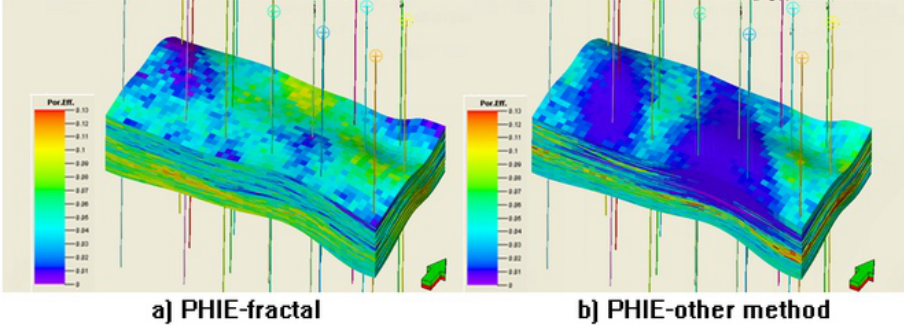
Fig. 12. Fractal and normal interpolation methods for the effective porosity (PHIE) distributions in the region of study.